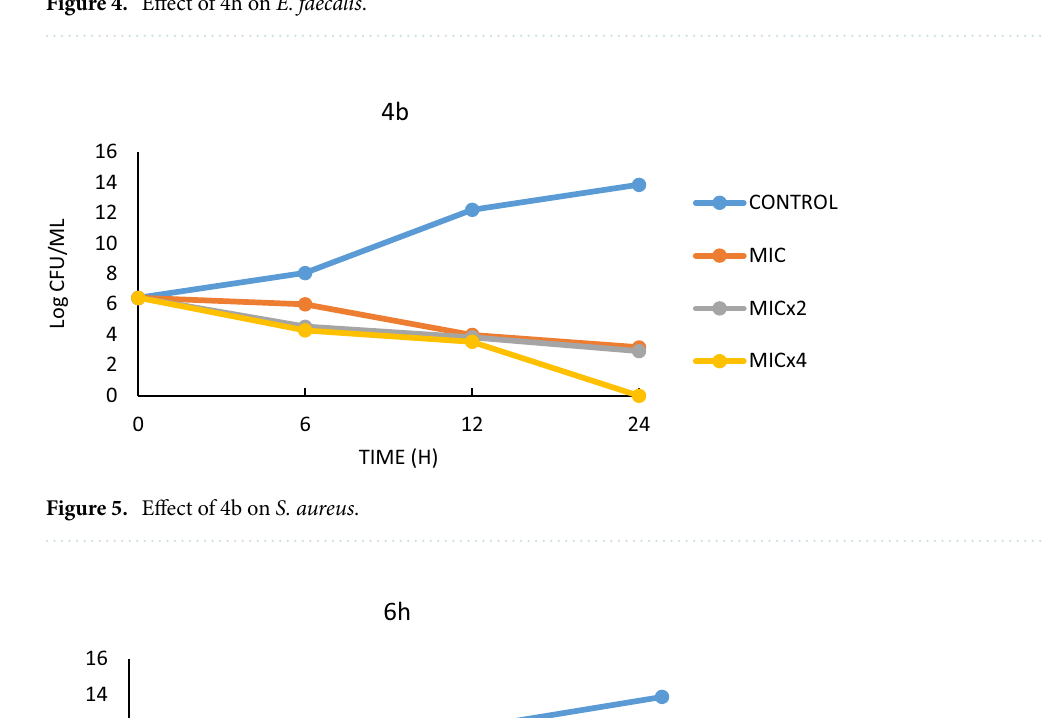
Figure 4. Effect of 4h on E. faecalis .